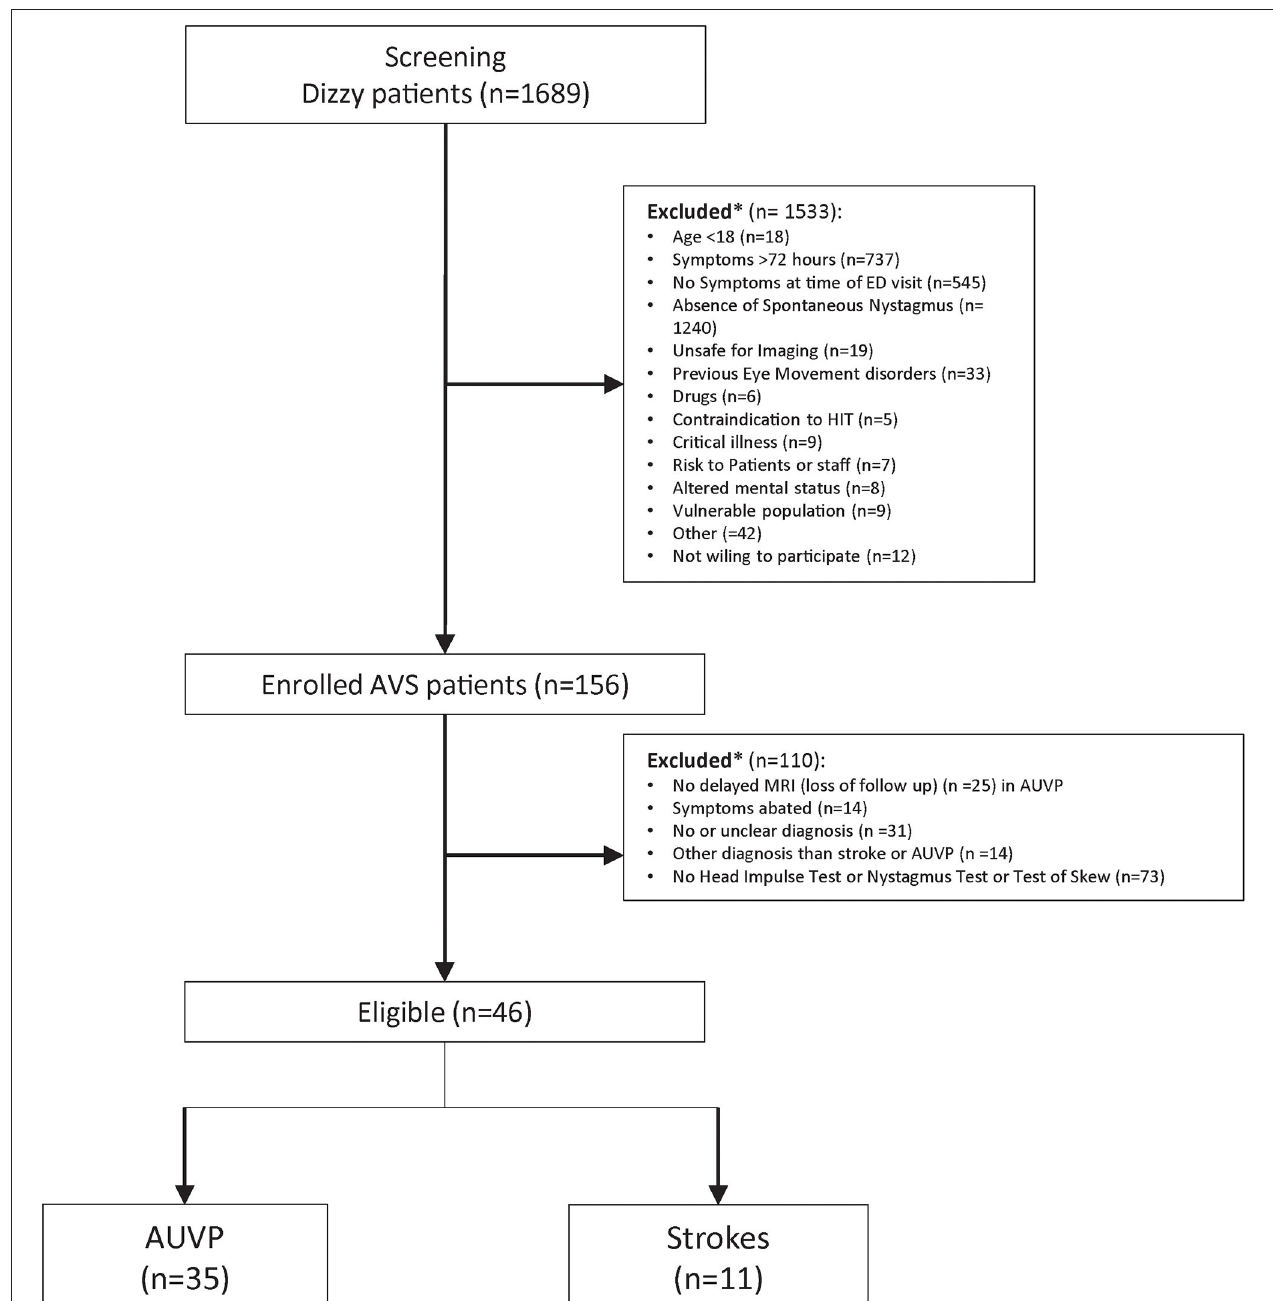
FIGURE 2 | Flowchart of all screened patients with dizziness and the inclusion and exclusion processes. *Patient could have had one or several reasons for